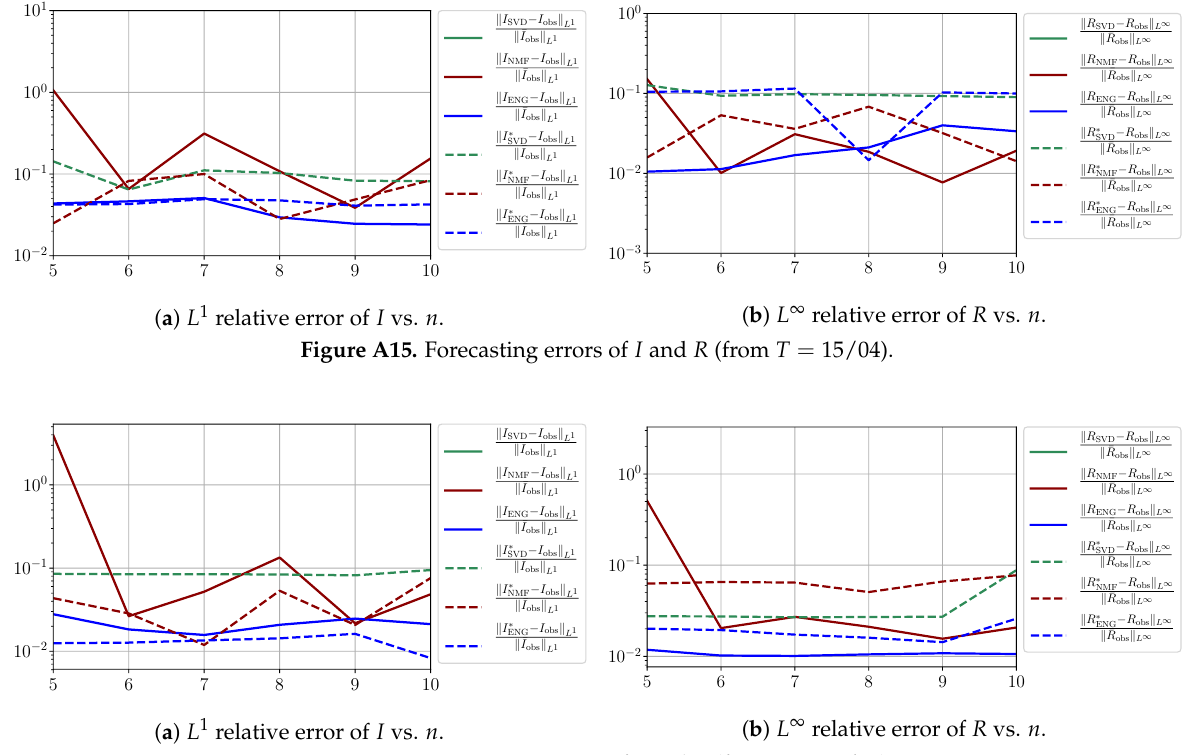
Figure A16. Forecasting errors of I and R (from T =